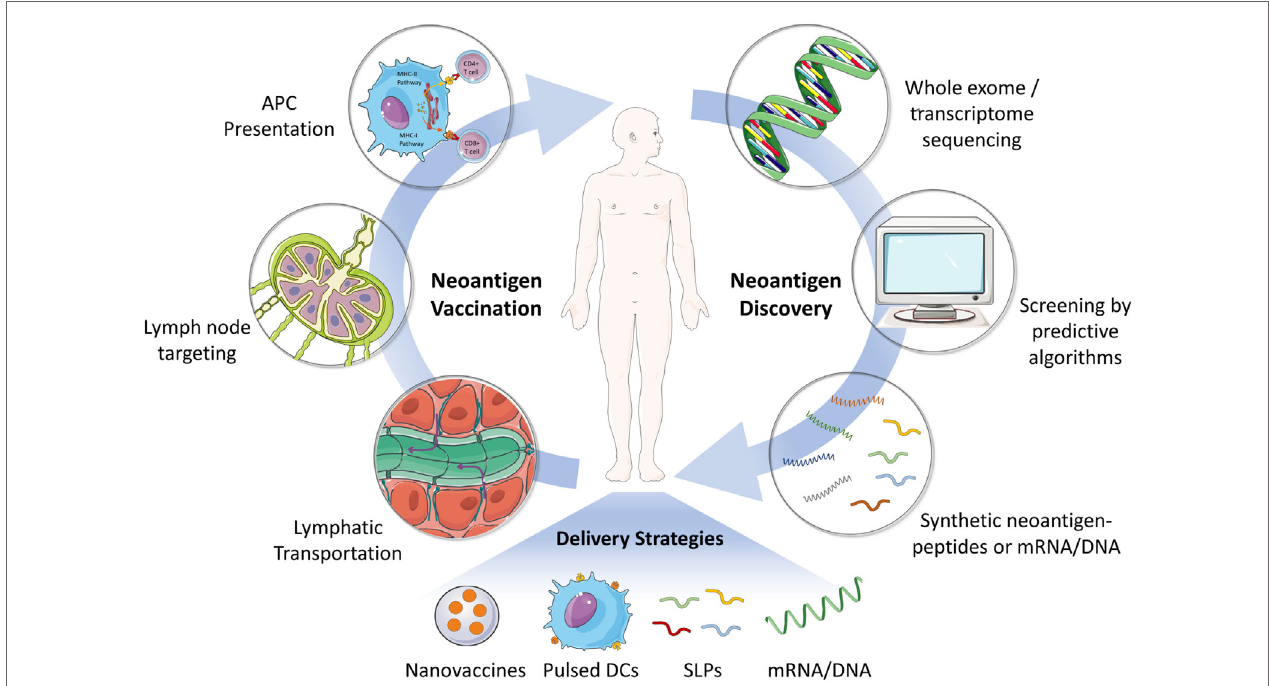
FiGURe 1 | Schematic illustration of the process of neoantigen discovery, vaccine manufacturing and formulation, and vaccination in patients. The first step for developing neoantigen cancer vaccine involves the identification of mutated tumor specific antigens by whole exome/transcriptome sequencing and prediction of immunogenic MHC epitopes. Next, neoantigen vaccines (e.g., SLP and mRNA) are manufactured and formulated for efficient delivery to secondary lymphoid organs (e.g., lymph node), where neoantigen vaccines are captured by APCs and presented to effector immune cells including CD8 + or CD4 + T cells. Various delivery strategies have been developed to achieve an effective and safe neoantigen-based cancer vaccine. Abbreviations: SLP, synthetic long peptide; DC, dendritic cell; APC, antigen-presenting cell; MHC, major histocompatibility